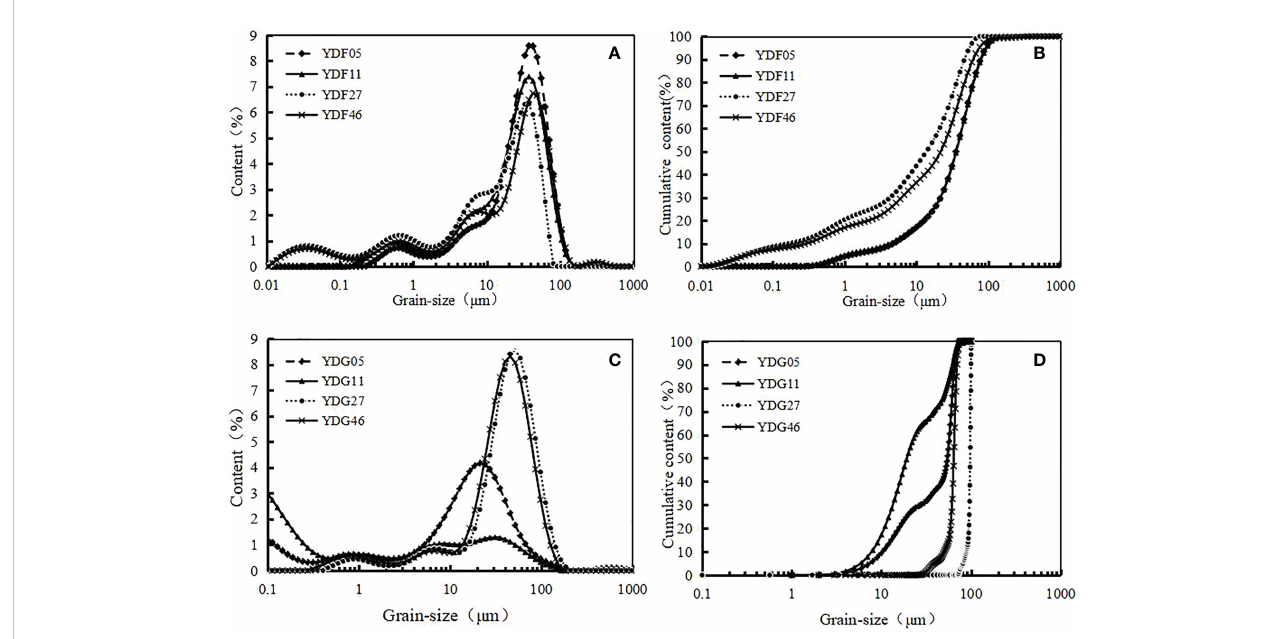
FIGURE 3 Grain-size distribution (A, C) and accumulative frequency curves (B, D) of cores YDC (A, B) and YDG (C, D) .